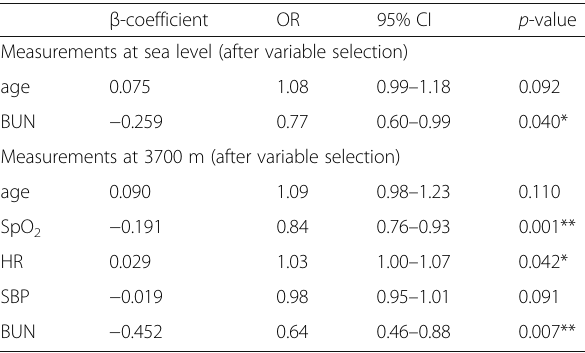
Table 5 Forward stepwise multivariate logistic regression for HAH at sea level and 3700 m ( N = 318)